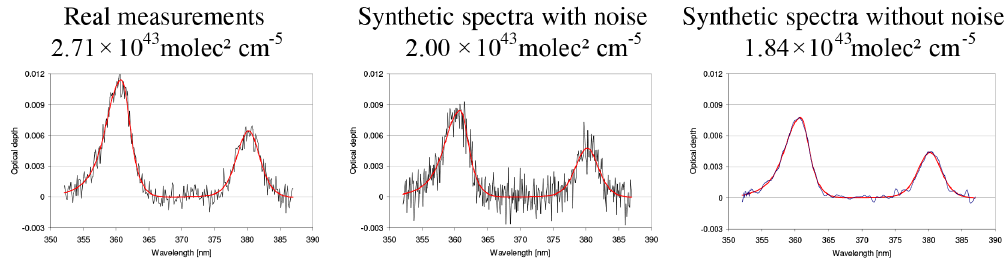
Figure 11. Spectral analysis results for a real measurement from the MPIC instrument (left) and a synthetic spectrum with and without noise. Spectra are taken from 8 July 2013 at 11:26 (elevation angle = 1 ◦ ). The derived O 4 dSCD is shown above the individual plots.